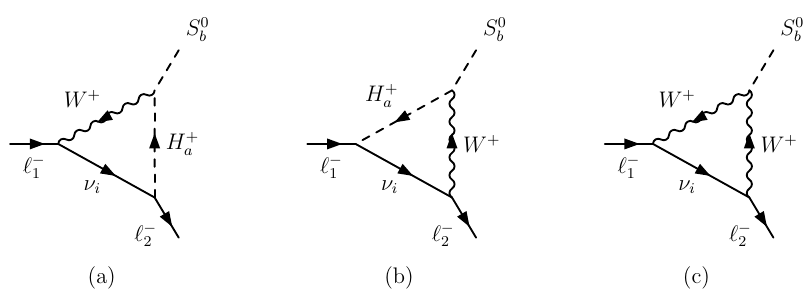
Figure 18 . Three diagrams for S 0